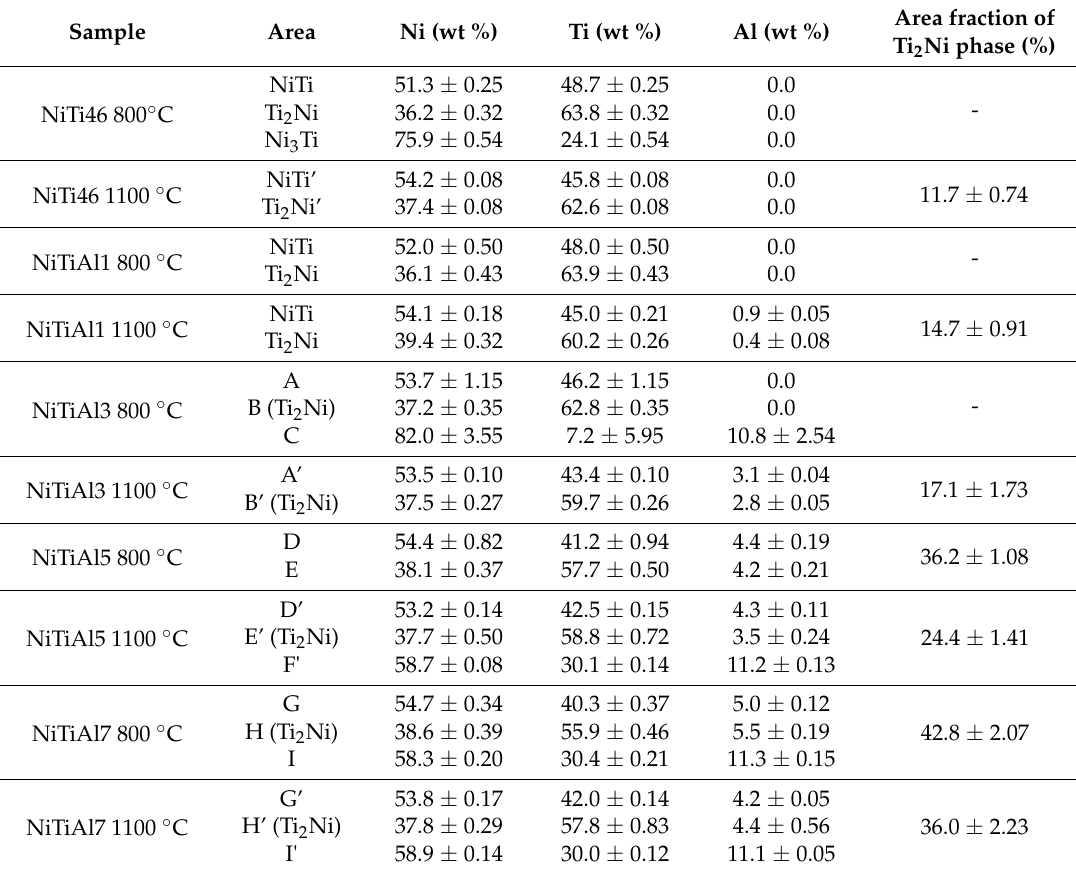
Table 1. Phase compositions and chemical compositions of individual phases of samples sintered at 800 and 1100 ◦